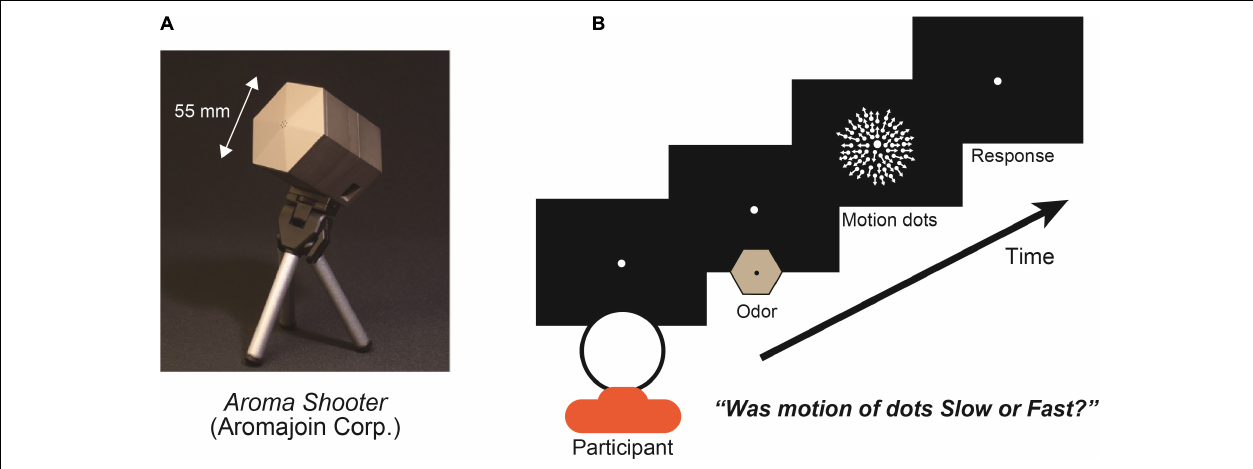
FIGURE 1 | (A) Aroma projector machine, “Aroma Shooter.” (B) Experimental paradigm: participant fixated on display’s center with/without an odor for 1.0 s viewed expanding-motion dots for 1.0 s and reported their subjective motion speed as either fast or slow. Between each trial, at least a 4.0-s interval was set to avoid olfactory